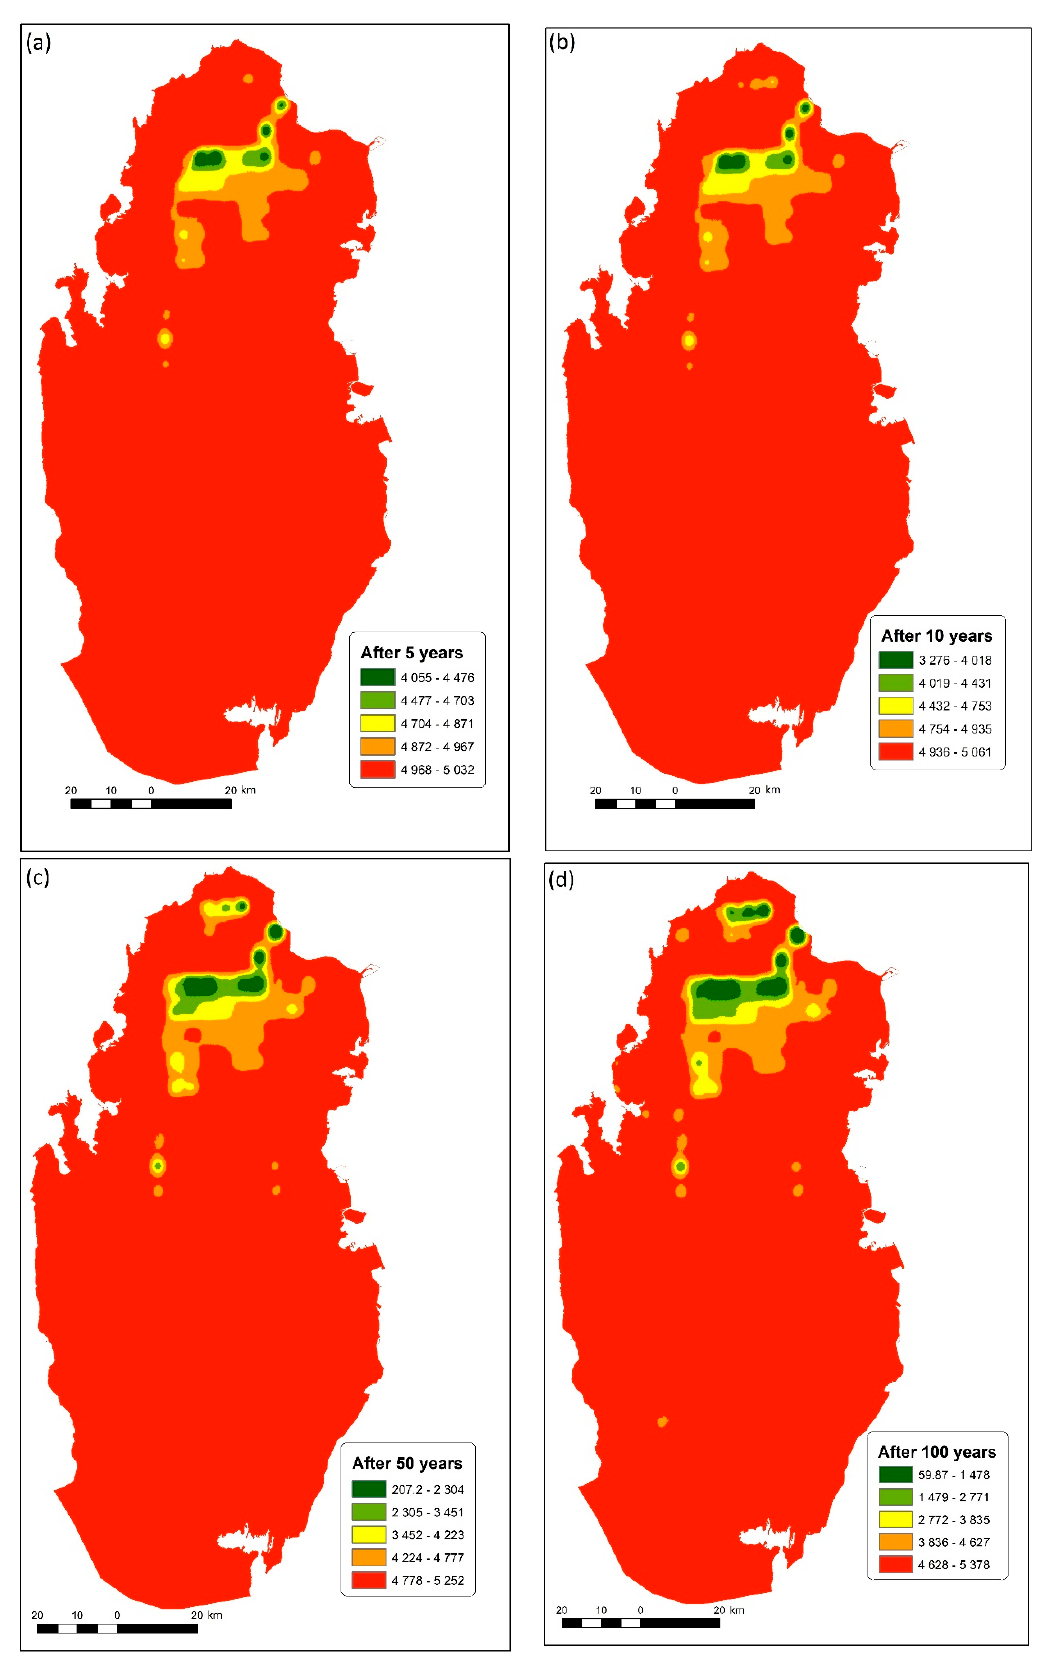
Figure 7. Simulated TDS (mg/L) at times ( a ) 5, ( b ) 10, ( c ) 50, and ( d ) 100 years.